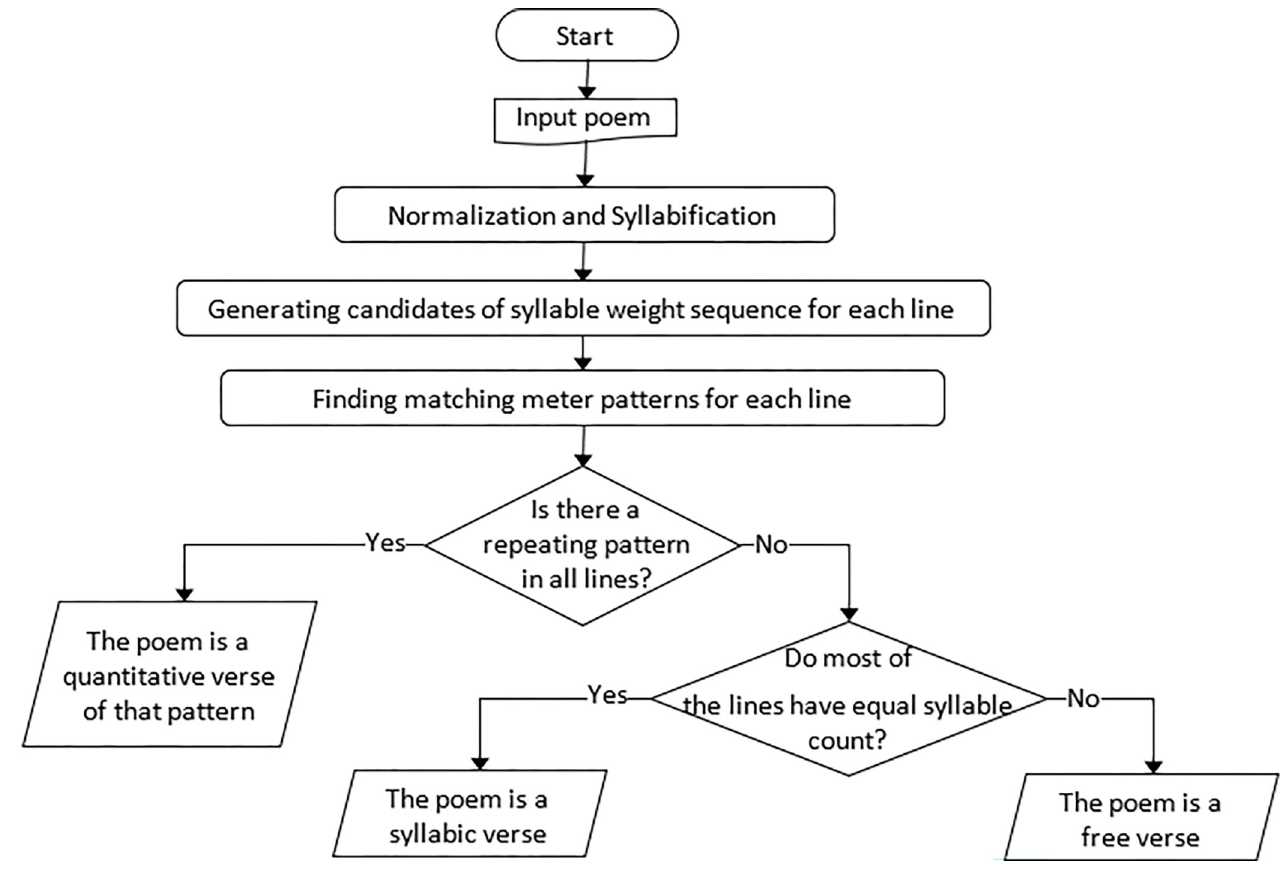
Fig 1. Flowchart of the proposed